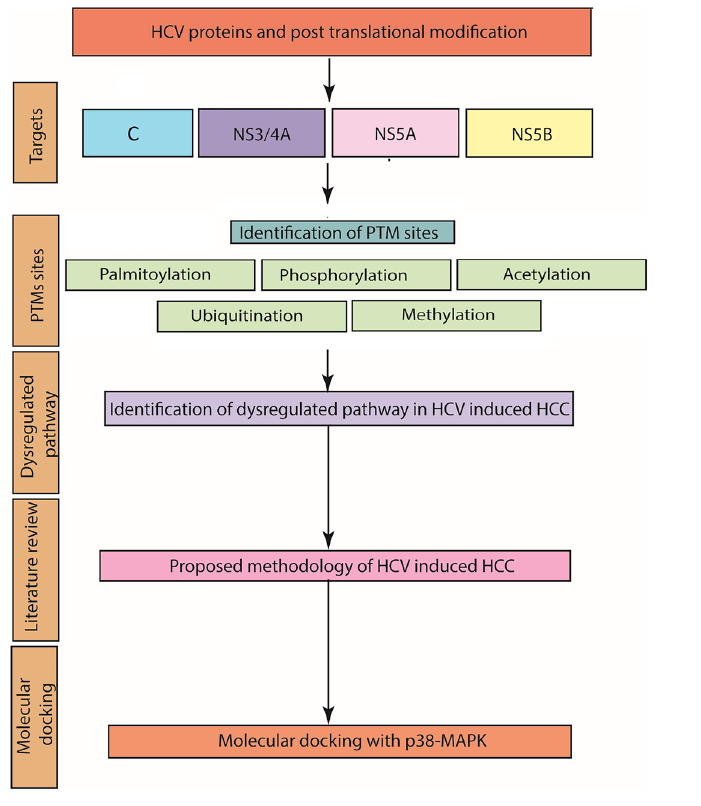
Figure 8. Overview of methodology adopted in our